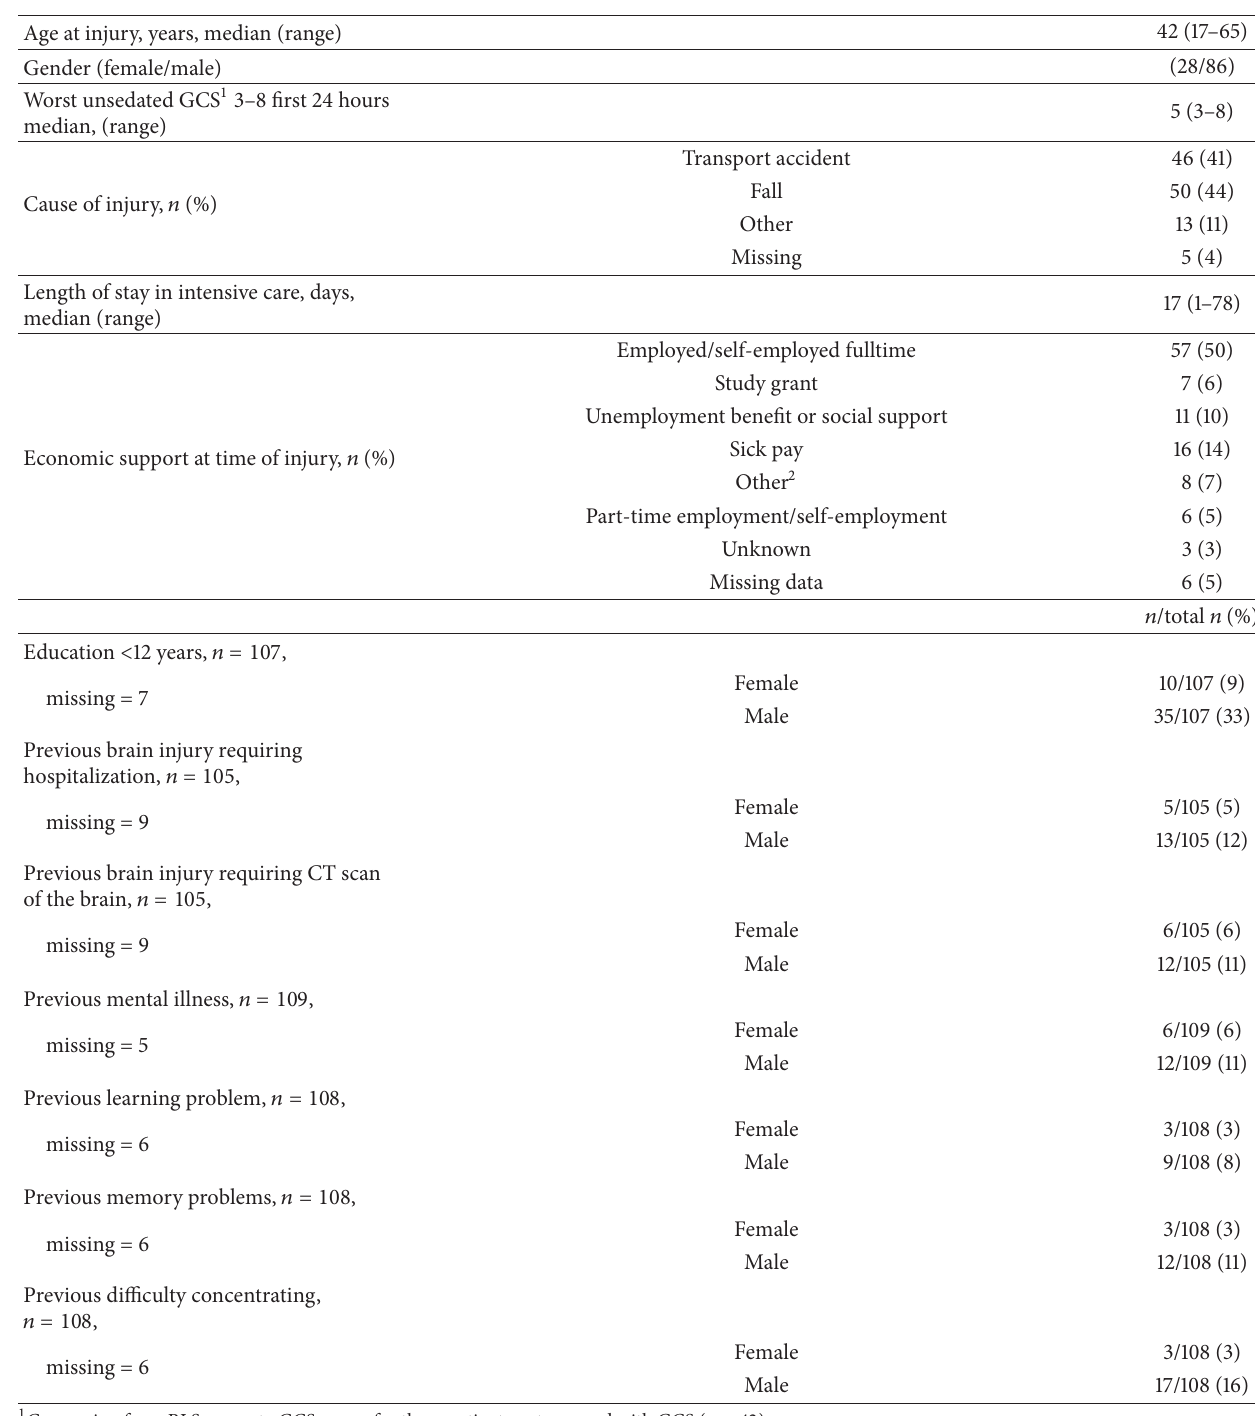
Table 2: Patient descriptors ( 𝑛 = 114